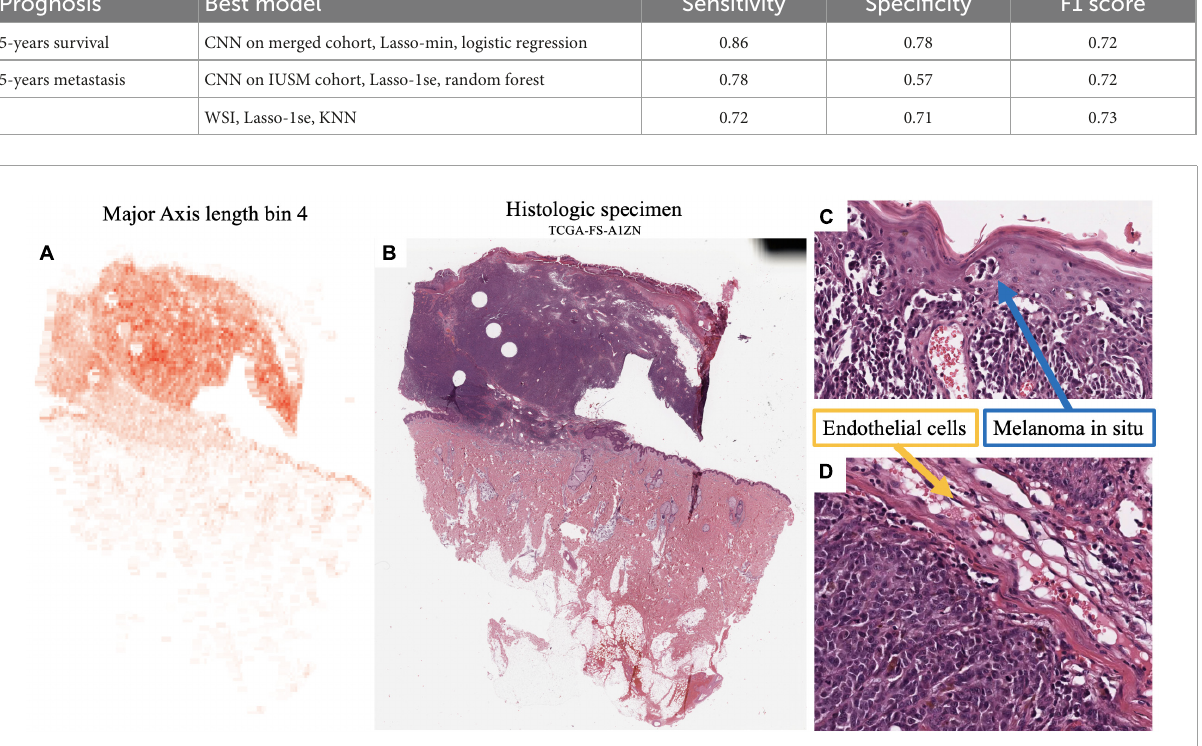
TABLE 3 The best models for survival and metastasis prognosis, among convolutional neural networks (CNN)-trained tumor region-only and whole slide images (WSI), LASSO-derived feature sets, and classifiers.